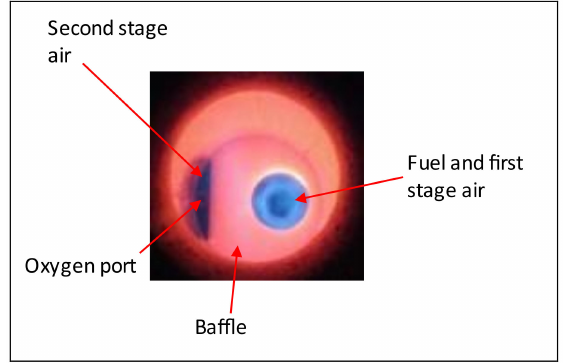
Figure 2. Image of the Bloom 1610 burner used for this